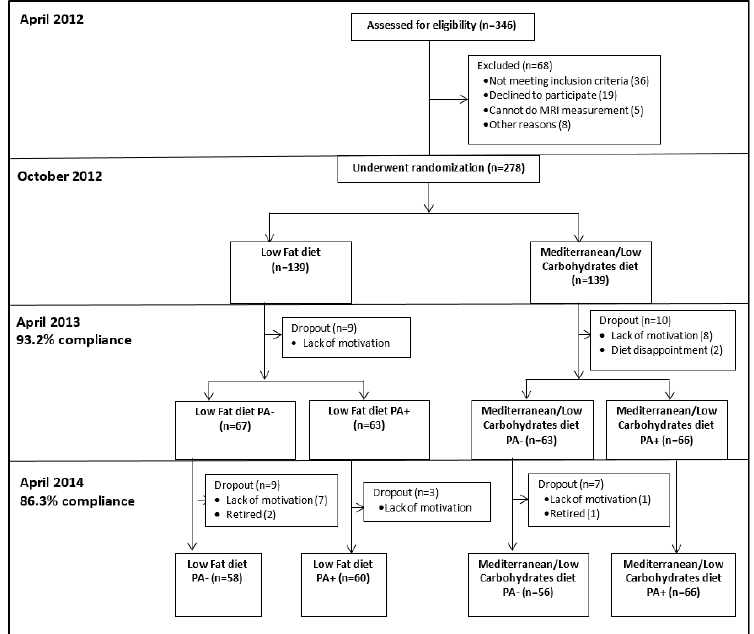
Figure 1. Flowchart of the CENTRAL